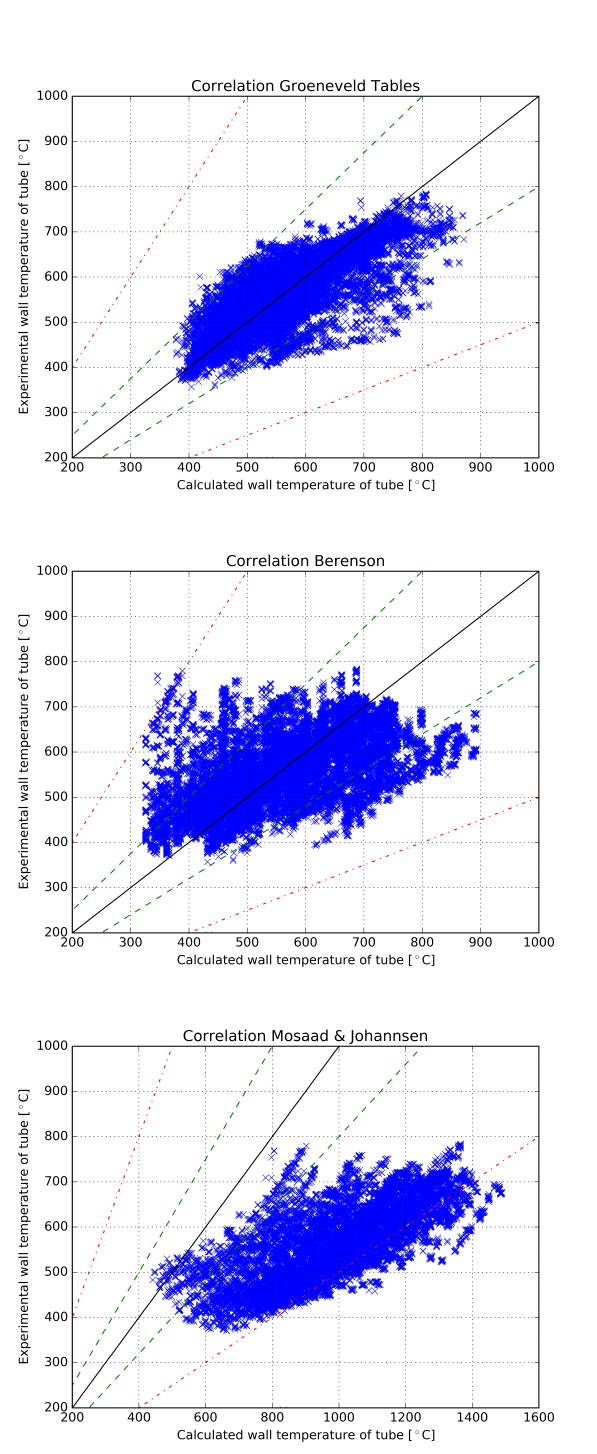
Figure 5. Comparison of experimental and calculated values of wall temperature with use of lookup tables and IAFB